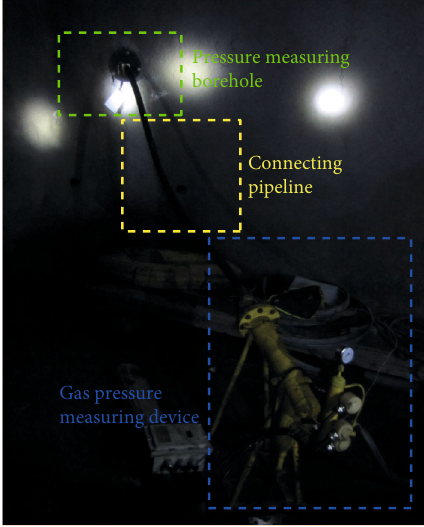
Figure 3: Schematic diagram showing underground connection of gas pressure measuring